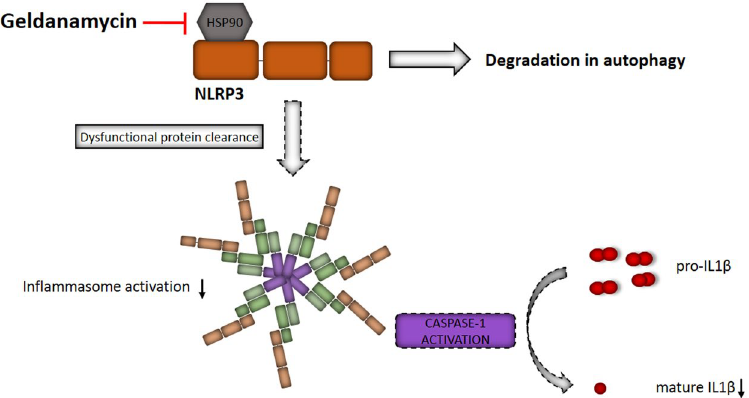
Figure 6. Summary of the effects of geldanamycin on inflammasome activation in human RPE cells. Inhibition of Hsp90 using geldanamycin led to the degradation of NLRP3 by autophagy, which prevented NLRP3 inflammasome signaling and reduced the secretion of mature IL-1 β